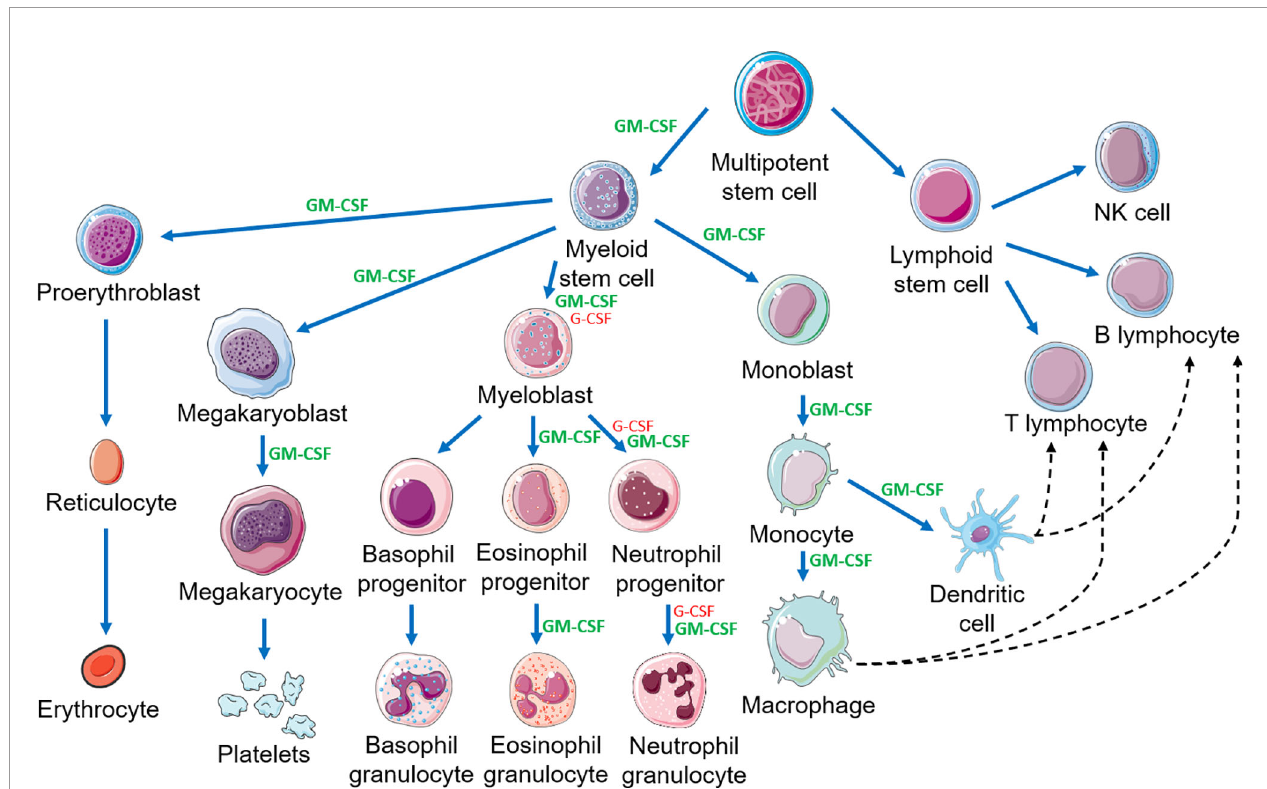
FIGURE 3 | Hematopoietic cascade demonstrating the action of GM-CSF and G-CSF and the link between the innate and adaptive immune systems. This fi gure is a partial representation of the hematopoietic cascade. NK, natural killer. This fi gure was created using Servier Medical Art templates, which are licensed under